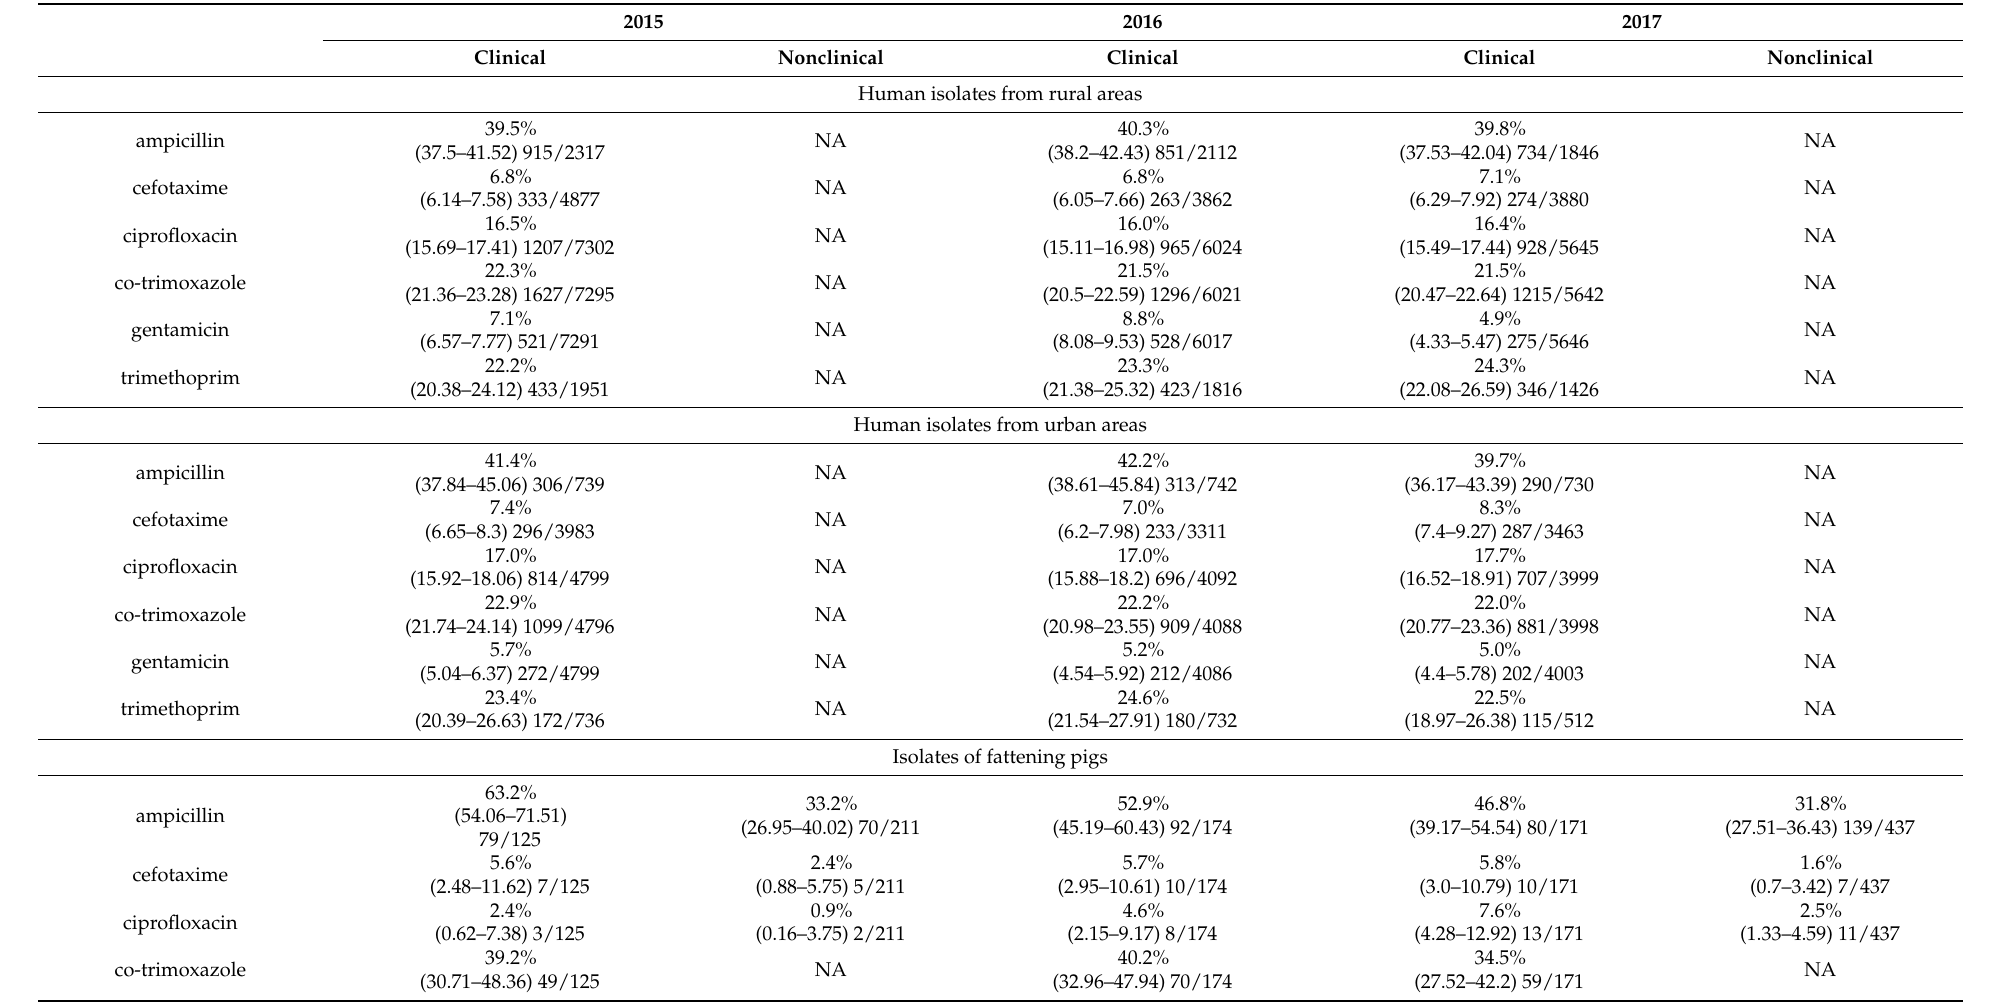
Table 1. Resistance proportions, 95% confidence intervals, number of resistant and number of tested E. coli isolates per antimicrobial of all populations (i.e., human areas: rural/urban; isolate type: clinical/nonclinical; pig categories: weaning/fattening) in Germany from 2015 to